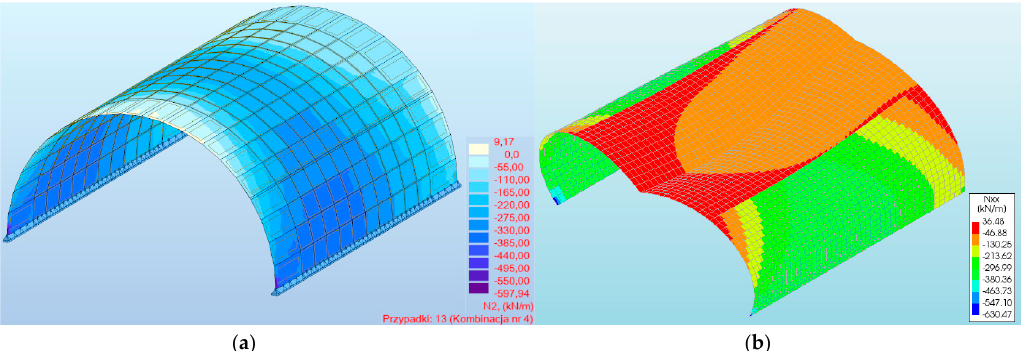
Figure 7. Maximum axial forces of a three-hinged arch obtained in the program: ( a ) #1, ( b ) #2.